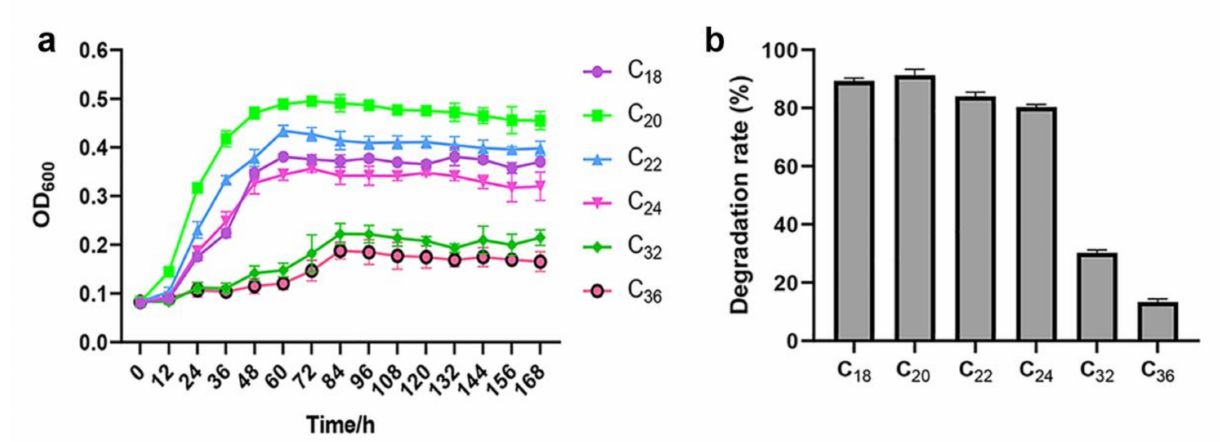
Figure 2. ( a ) Growth curves of sw-1 in 500 mg/L of various n -alkanes (C 18 –C 36 ). Strain sw-1 was inoculated in 50 mL of BSM containing 500 mg/L of n -alkanes. All flasks were incubated at 30 ◦ C for 7 d. The strain growth was determined by estimating OD 600 of cells every 12 h. ( b ) Degradation rate of various n -alkane. The residual alkanes in BSM were extracted using n -hexane and were detected using gas chromatograph, and the degradation rate of alkanes was determined by deducting the mass of residual alkanes from the initial